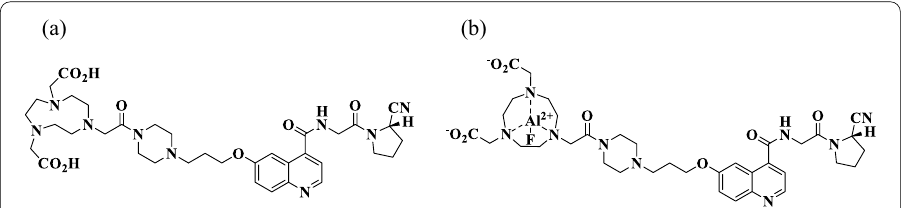
Fig. 1 Structures of the FAPI-74 precursor and the reference standard of AlF-FAPI-74. a The precursor was bound 1,4,7-triazacyclononane-N, N ′ ,N ′ -triacetic acid (NOTA) as a chelating agent. b The reference